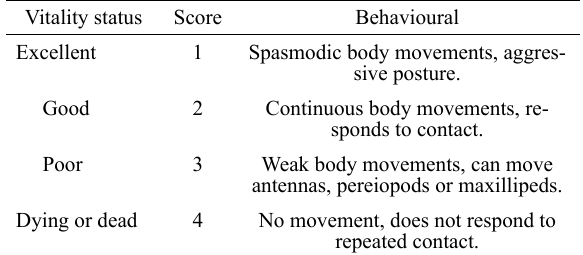
2. – Wilcoxon rank-sum test for comparison of control with treatment 1 (T1) and treatment 2 (T2) through the